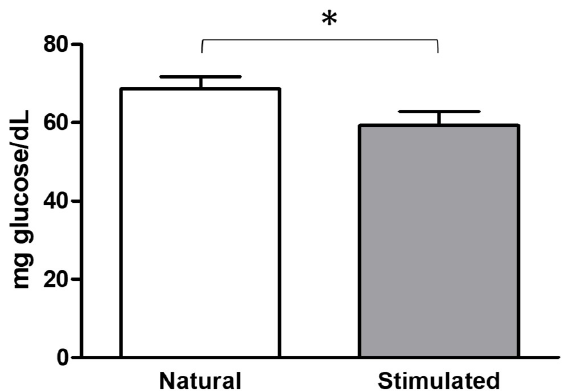
Figure 5. Glucose concentration in follicular fluid from women undergoing both a natural cycle and a stimulated cycle. Bars represent the mean + SE. * p <